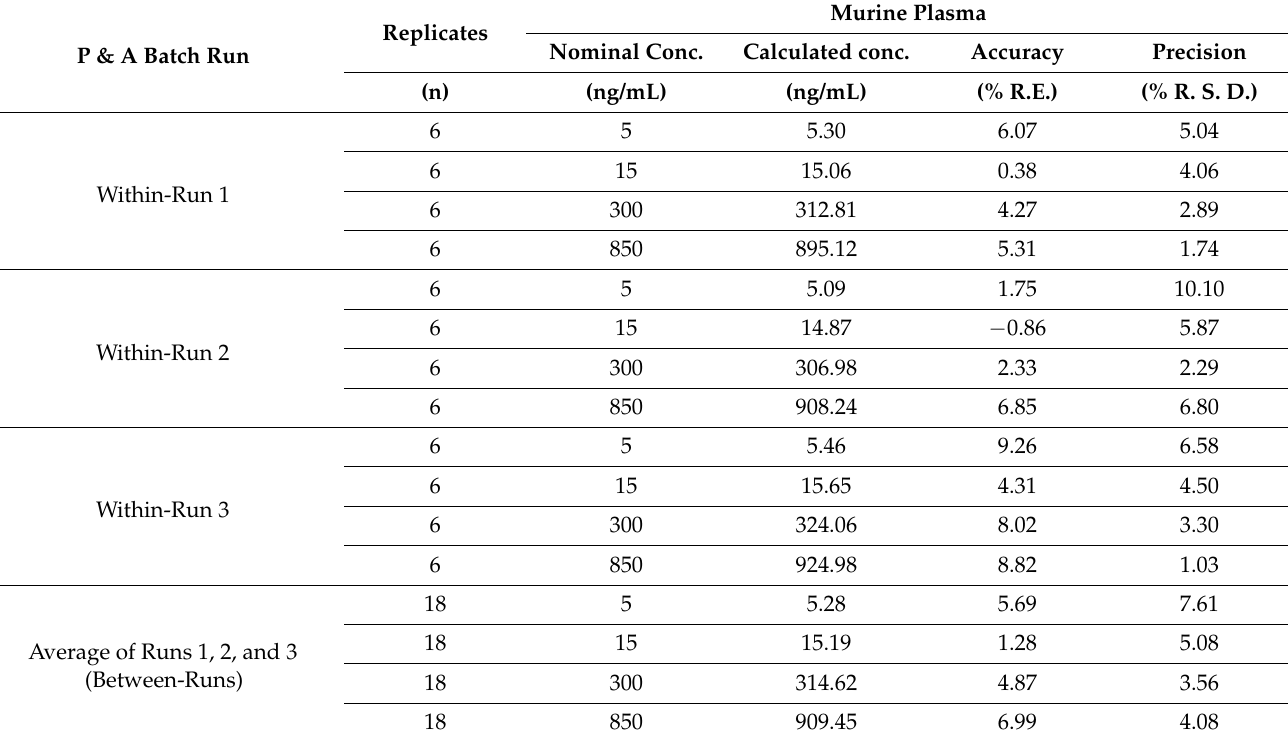
Table 2. Within-run and between-run precision and accuracy for IWR-1-endo in murine plasma (n = 6 for within-run and n = 18 for